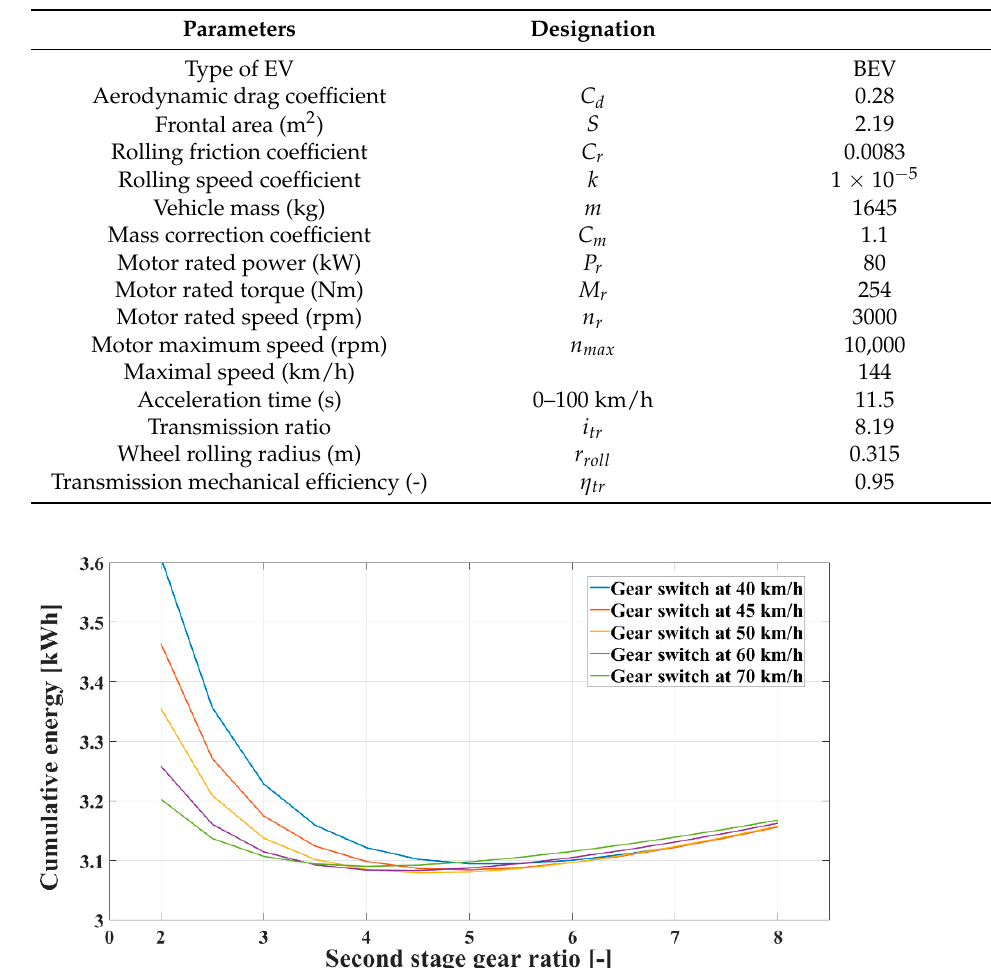
Table 3. Main vehicle data.